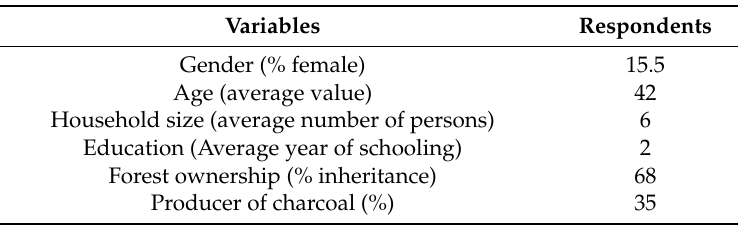
Table 2. Major characteristics of the respondents.